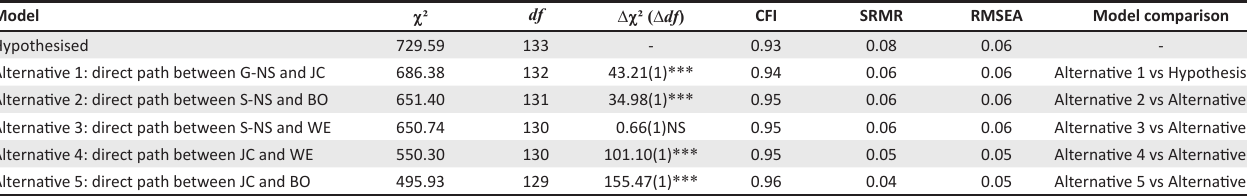
TABLE 5: Fit indices for structural models ( N = 1500). Model Model